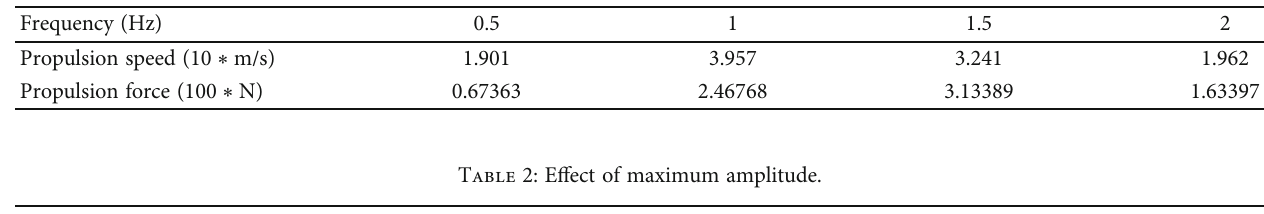
Figure 8: Velocity and pressure contours at the main view interface. (a) The values of frequency, amplitude, and phase are 1.5Hz, 0.2m, and 0 degrees, respectively. (b) The values of frequency, amplitude, and phase are 0.5Hz, 0.2m, and 0 degrees, respectively. (c) The values of frequency, amplitude, and phase are 1.5Hz, 0.2m, and 70 degrees and 0.5 Hz, 0.1m, and 0 degrees, respectively. (d) The values of frequency, amplitude, and phase are 1.5 Hz, 0.2m, and 20 degrees, respectively. Table 1: In fl uence of beat frequency.